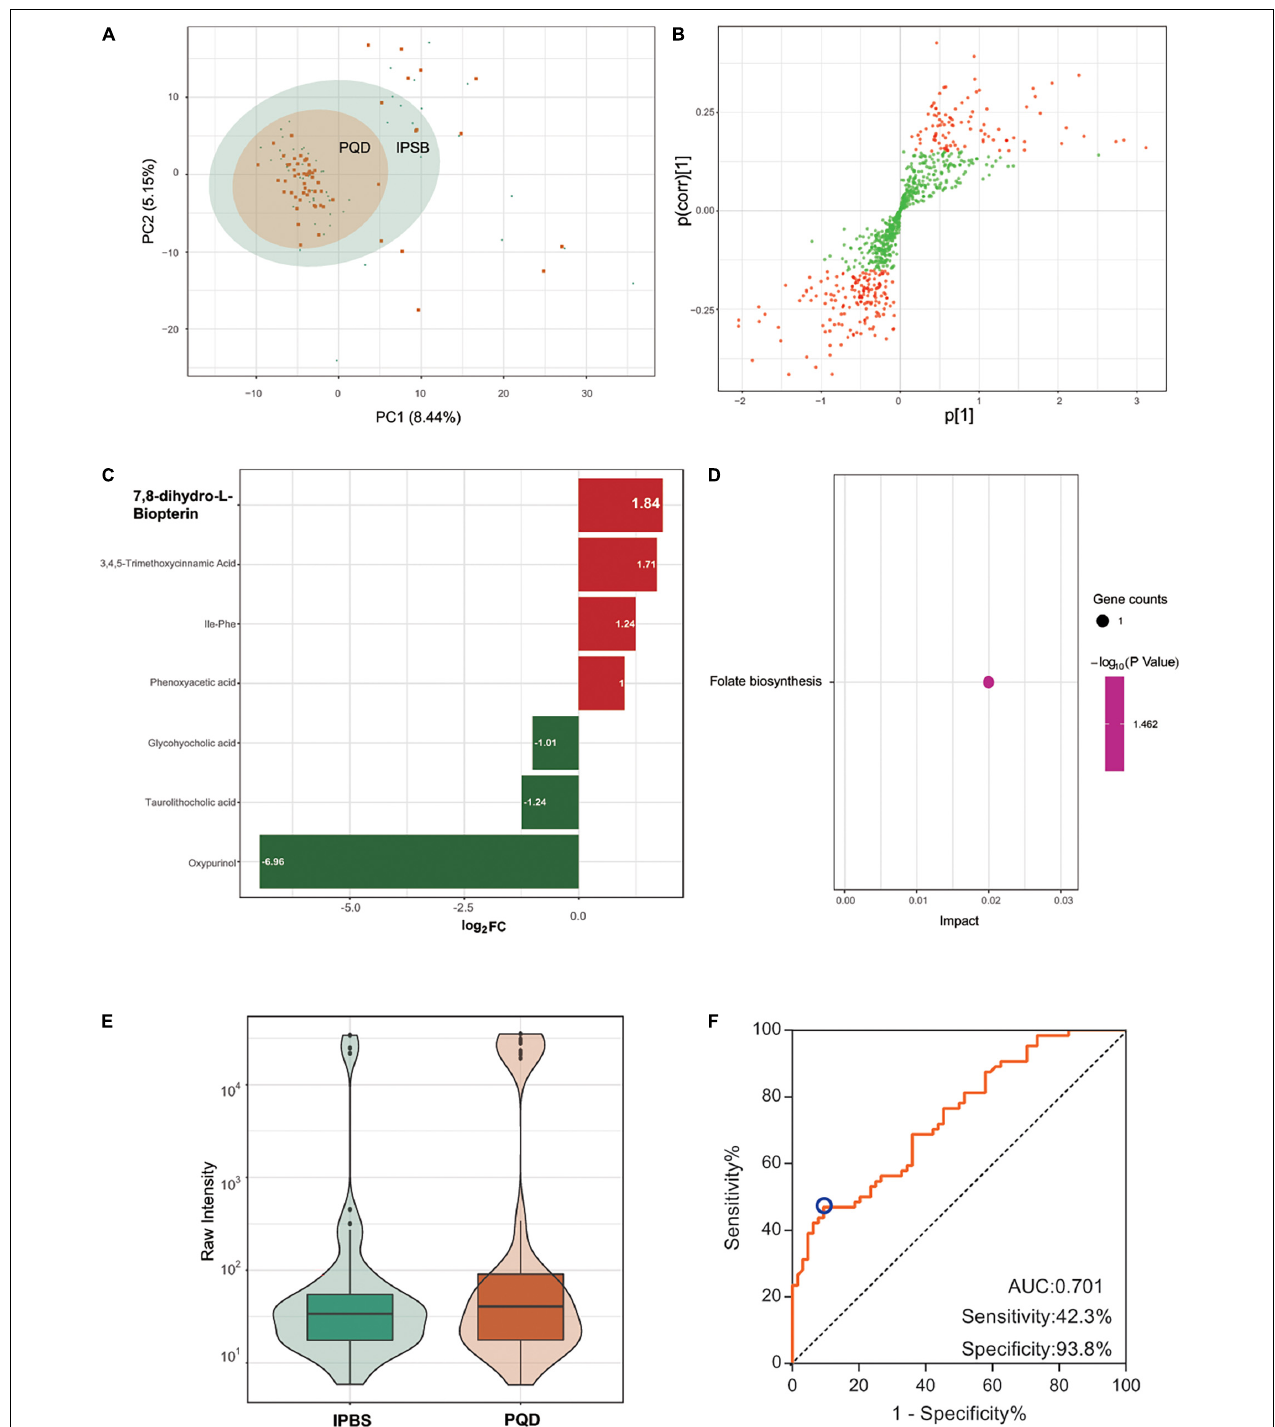
FIGURE 5 | Comparison between IPBS and PQD. (A) The PCA plot between IPBS and PQD. Each point in the graph represents a sample, the different colors of the points represent the grouping of the samples, the differences are not distinct in the plot. (B) OPLS-SPlot between IPBS and PQD. VIP > 1, red plots represent different regulated metabolites. (C) The column chart shows different regulated metabolites between IPBS and PQD. Red bars represent upregulated metabolites in PQD, green bars represent downregulated metabolites in PQD. Data are shown in log2 scale. (D) KEGG analysis of different regulated metabolites between IPBS and PQD; folate biosynthesis was the most enriched pathway. (E) The violin diagram shows the most significantly upregulated metabolites. 7,8-dihydro-L-biopterin is the top upregulated metabolite in PQD. (F) ROC curve of the prediction model to identify IPBS and PQD. AUC is 0.701, sensitivity is 0.423, and specificity is 0.938; the blue circle represents the truncation